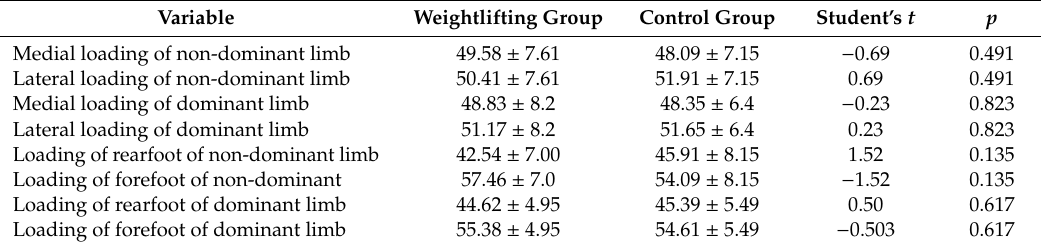
Table 6. Dynamic plant pressure distribution of the dominant and non-dominant limb and between-group comparisons (Student’s t and p value).